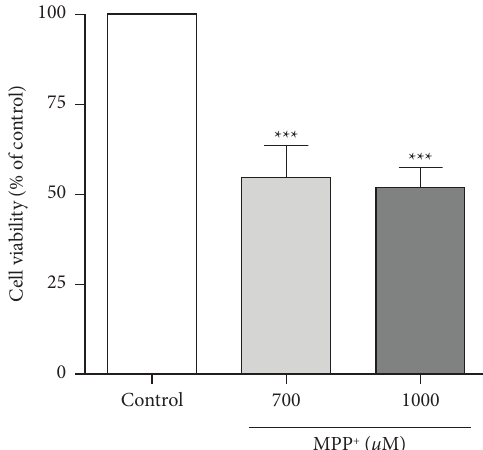
Figure 2: Efects of MPP + on cell viability in diferentiated SH-SY5Y cells. Diferentiated SH-SY5Y cells were treated with MPP + at 700 and 1000 μ M for 24hours. After treatment, cell viability was measured by using MTT assay. Values represent mean ± SEM ( n � 3 with fve replicates each). ∗∗∗ p < 0 . 001 compared with the control